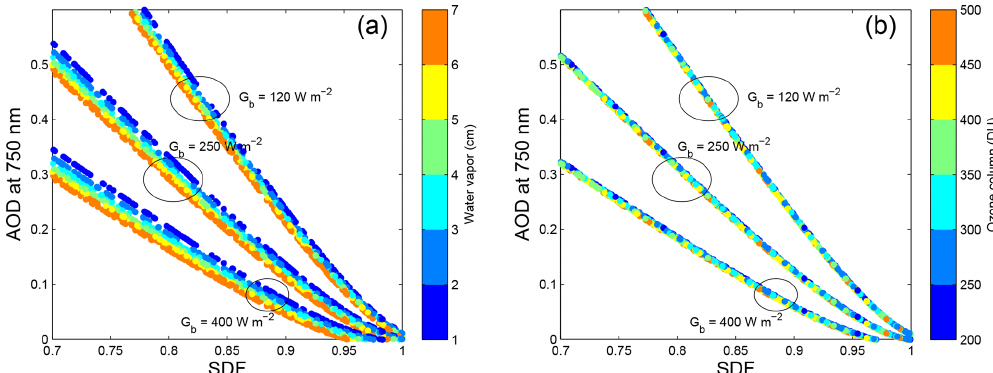
Figure 3. Same as Fig. 2 but varying (a) water vapor and (b) ozone contents. Table 1. Description of AERONET stations used and ordered by decreasing latitude. ID